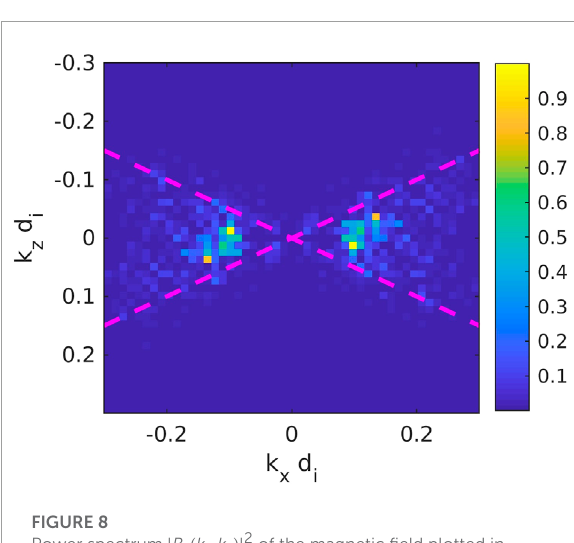
FIGURE 8 Power spectrum | B z ( k x , k z )| 2 of the magnetic field plotted in Figure 7A . The dashed magenta lines indicate where the propagation angle is 30 ° with respect to the background field B x